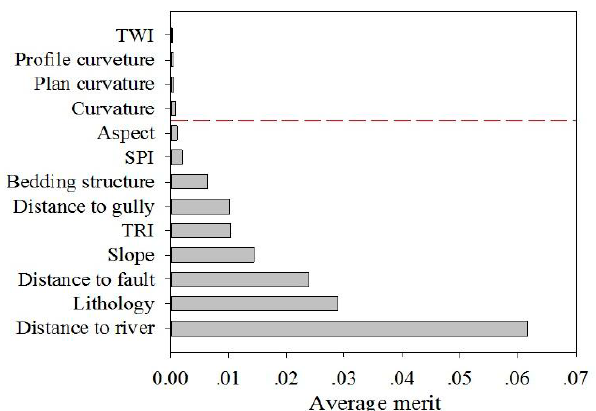
Figure 3. The average merit of each causal factor.